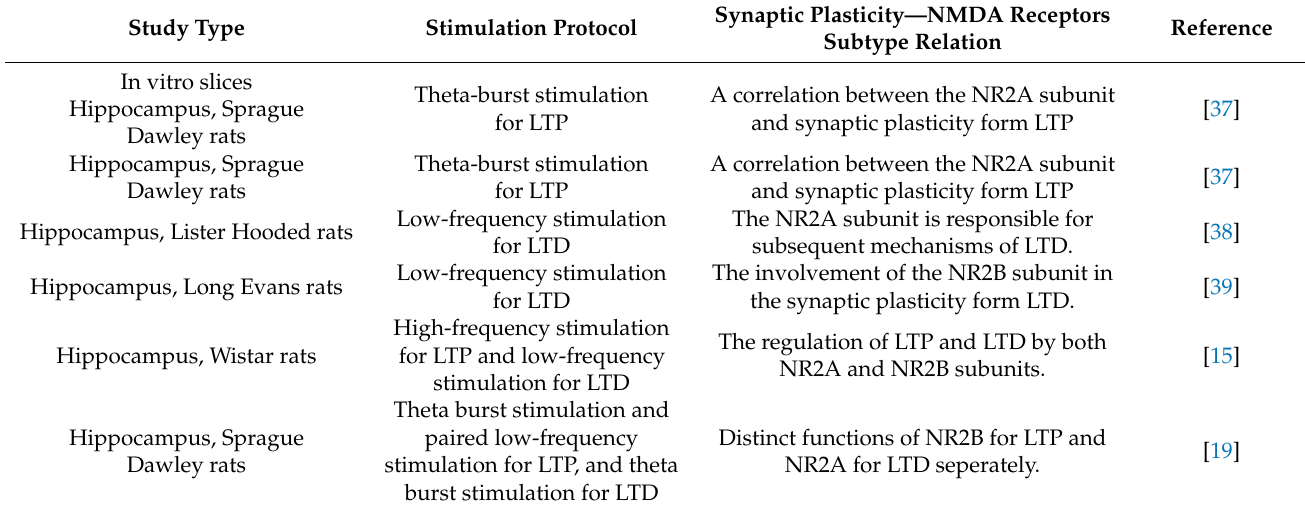
Table 1. Example of disparate properties of plasticity synaptic forms associated with NMDAR containing NR2 subunits